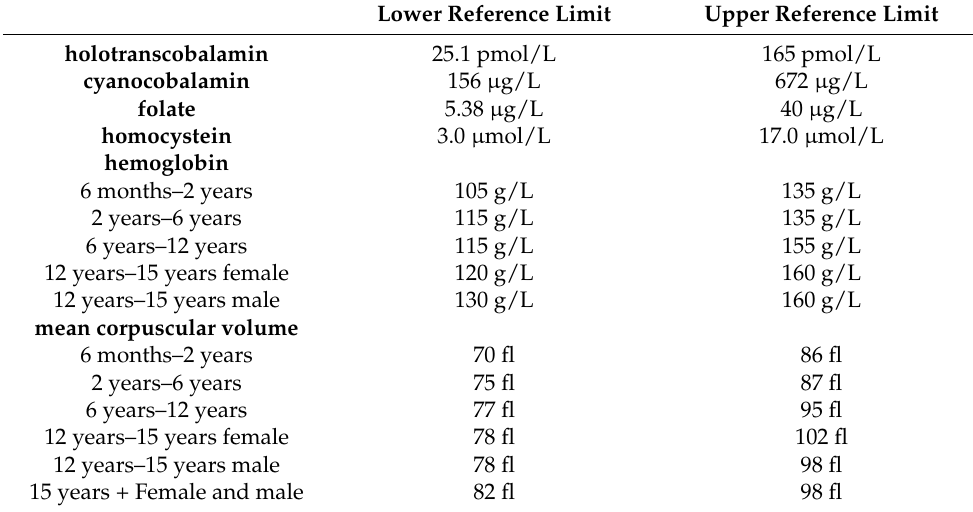
Table 2. Reference intervals of the laboratory